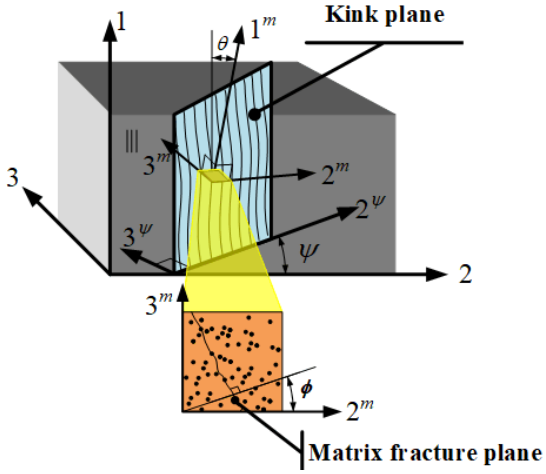
Figure 2. 3D kinking model based on [32].